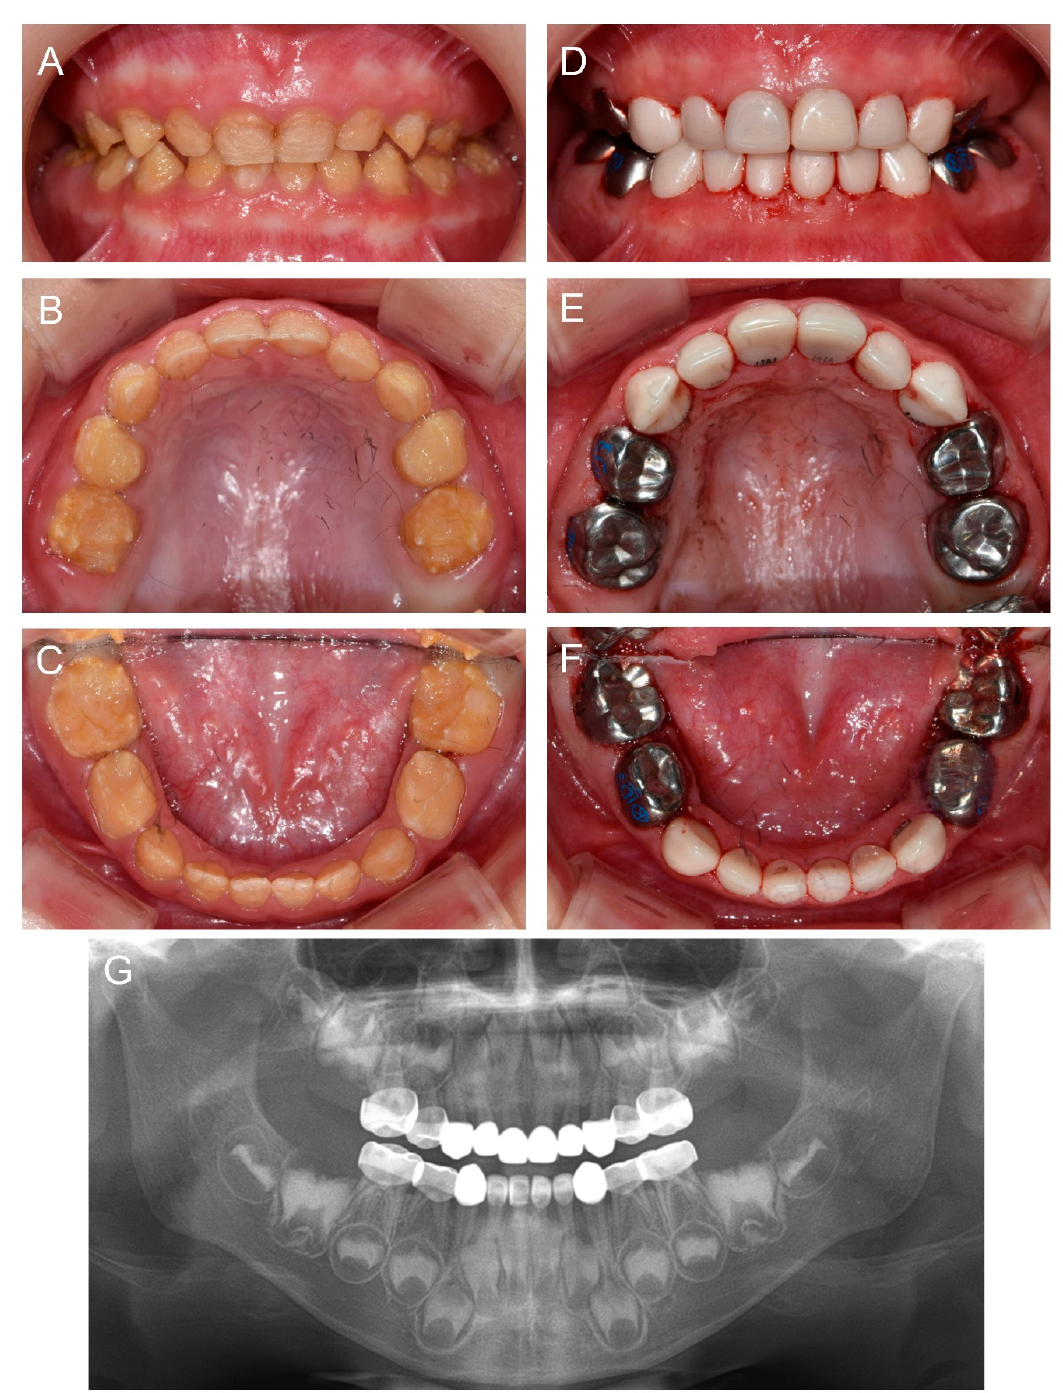
Figure 4. Clinical photos and panoramic radiograph of the affected individual (IV:1). ( A – C ) Clinical photos of the proband before the treatment at age 2 years 11 months. ( D – F ) Clinical photos of the proband after the treatment. The deciduous molars were treated with stainless steel crowns, and the deciduous canines and maxillary anterior teeth were treated with zirconia crowns. The deciduous mandibular anterior teeth were treated with celluloid resin crowns. ( G ) Panoramic radiograph at age 4 years 9